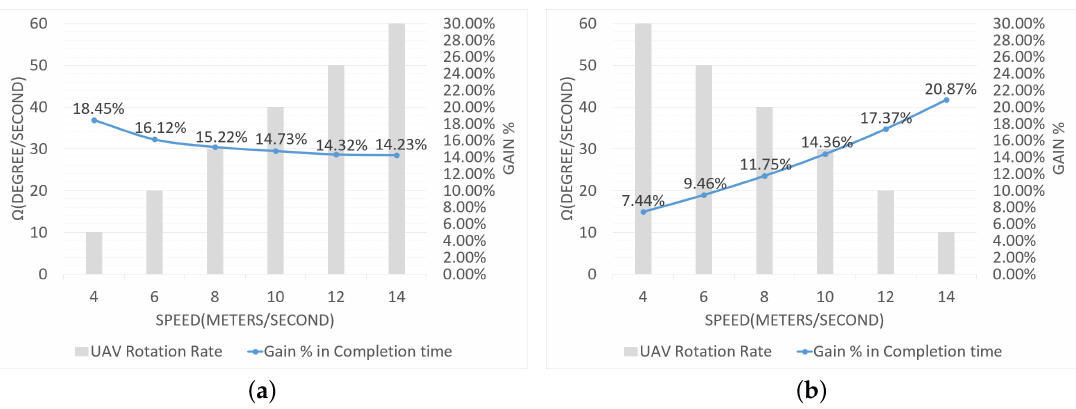
Figure 23. Gain in completion time. ( a ) gain in completion time in our work compared to [31] while increasing both speed and rotation rate; ( b ) gain in completion time in our work compared to [31] while increasing speed and decreasing rotation